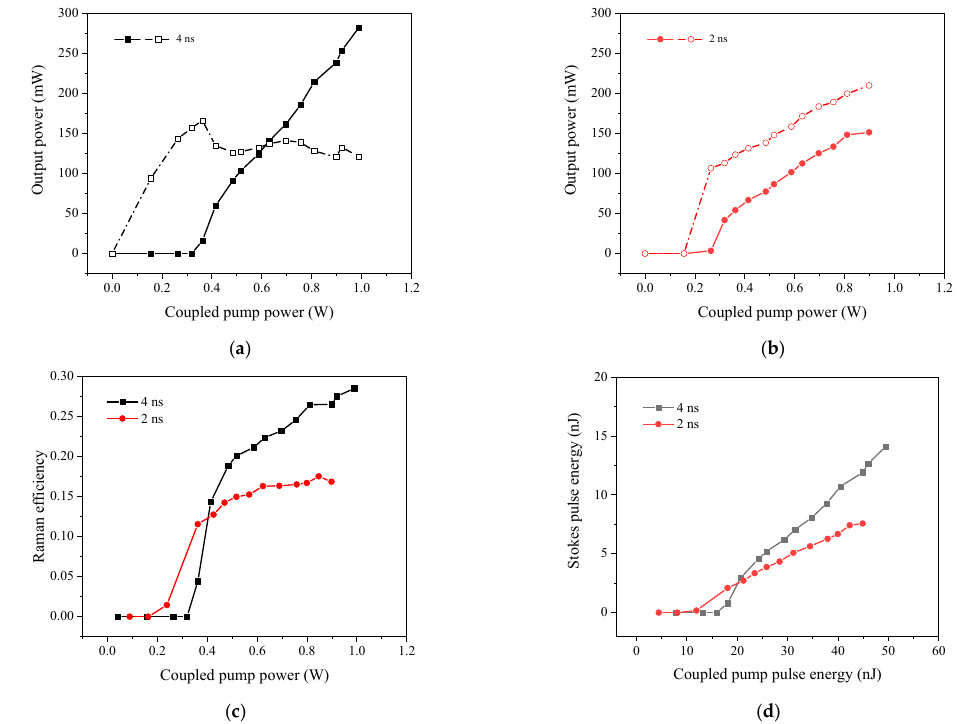
Figure 7. The output power characteristics of the FGRL with the pulse width of ( a ) 4 ns and ( b ) 2 ns. The solid and hollow patterns represent the Raman power and residual pump power, respectively. ( c ) The Raman efficiency of different pulse widths. ( d ) The Stokes pulse energy with coupled pump pulse energy in different repetition frequency.